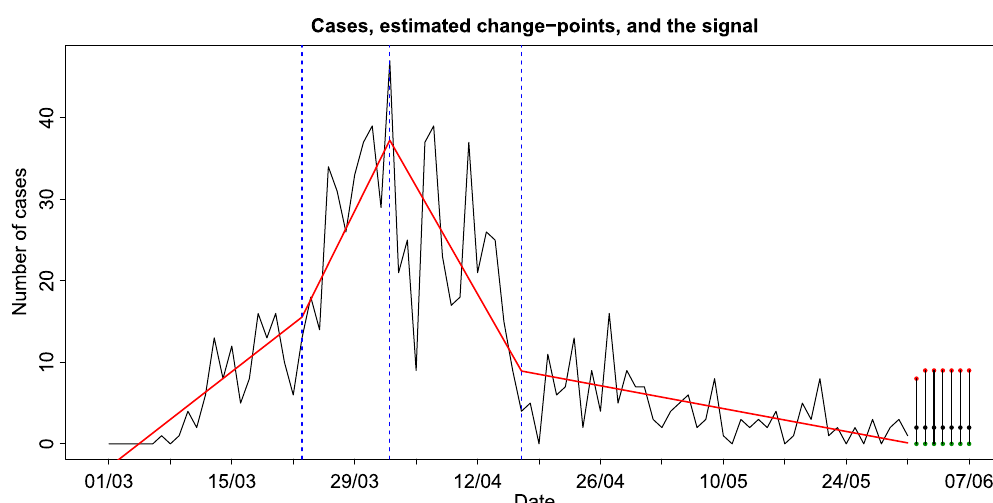
Figure 4. (Left plot ) The recovery rate ( days − 1 ) (blue stars) and the corresponding fitted function (9) (red solid line). (Right plot) Exposed E ( t ) and infectious I ( t ) cases.